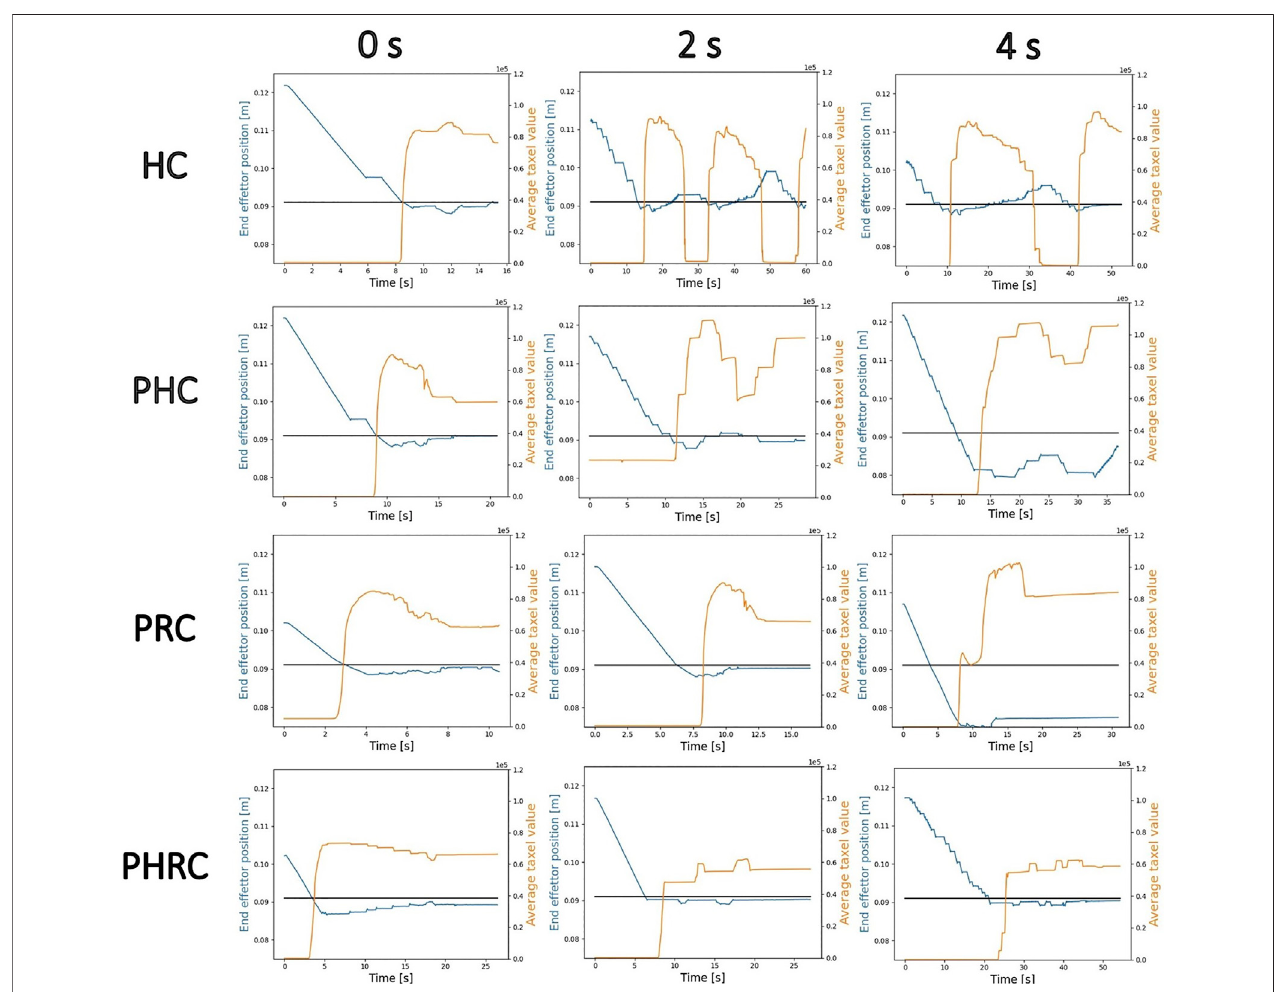
FIGURE6| Examplesoftrials fordifferent delays and allfour different controlmodalities: each row represent acontrolmodalityand each column represent adelay condition. In blue the z position of the end-effector and in orange the sum of the taxels ’ value. The black line indicates the position of the dummy ’ s surface.